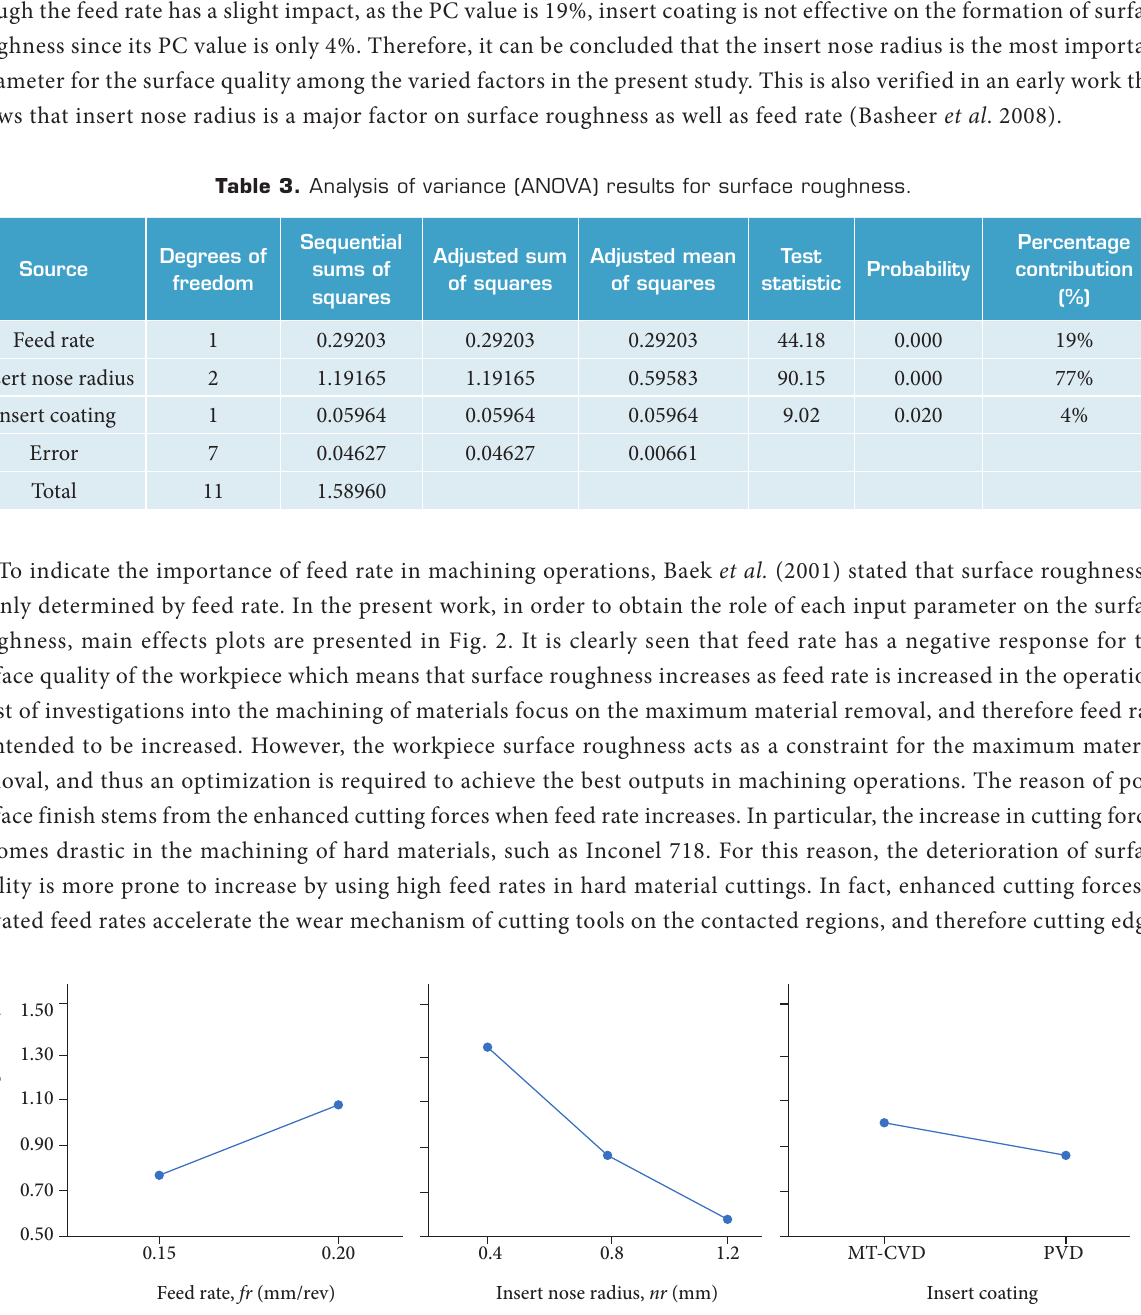
Figure 2. Main effects plot for surface roughness ( Ra ). MT-CVD = Medium temperature chemical vapor deposition; PVD = Physical vapor